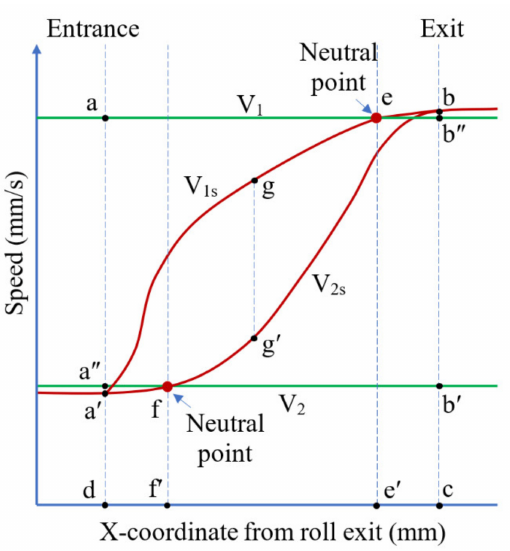
Figure 18. Schematic illustration of speed profiles in deformation zone during differential speed rolling, reproduced from [57], with permission from Elsevier,